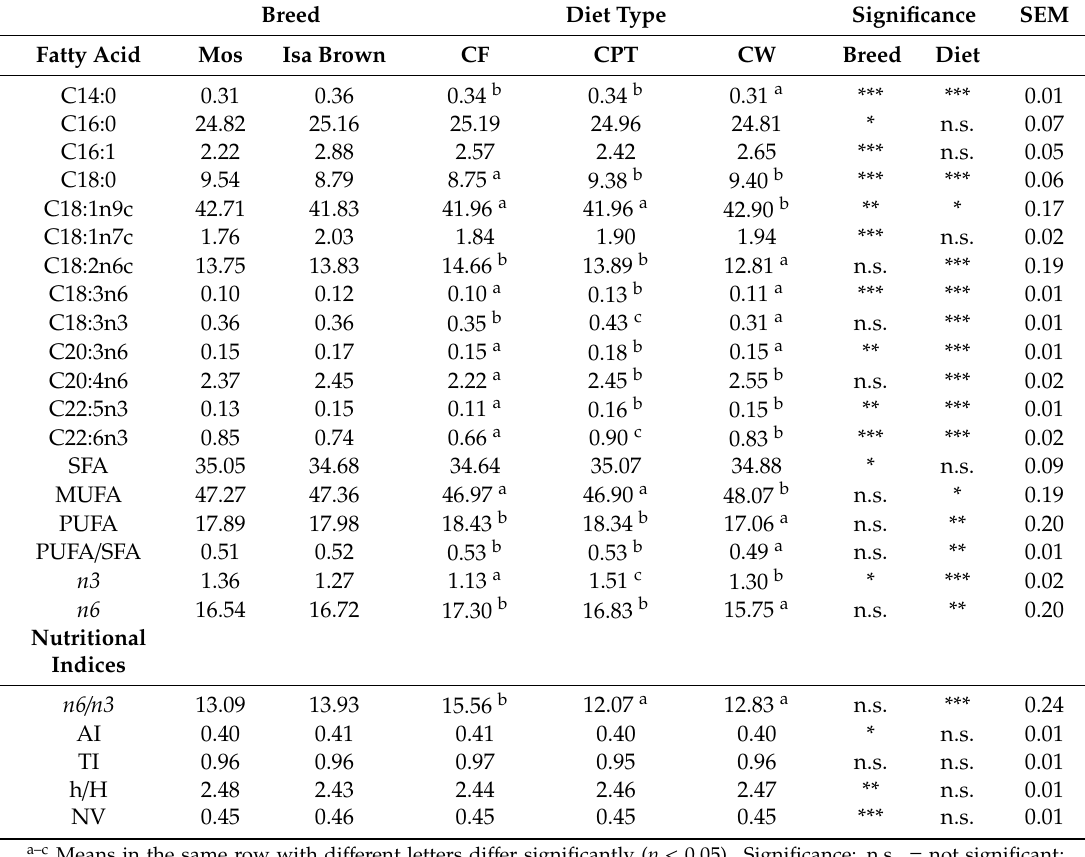
Table 6. E ff ect of breed (Mos vs. Isa Brown) and diet type (CF, CPT and CW) on egg fatty acid profile. Breed Diet Type Significance